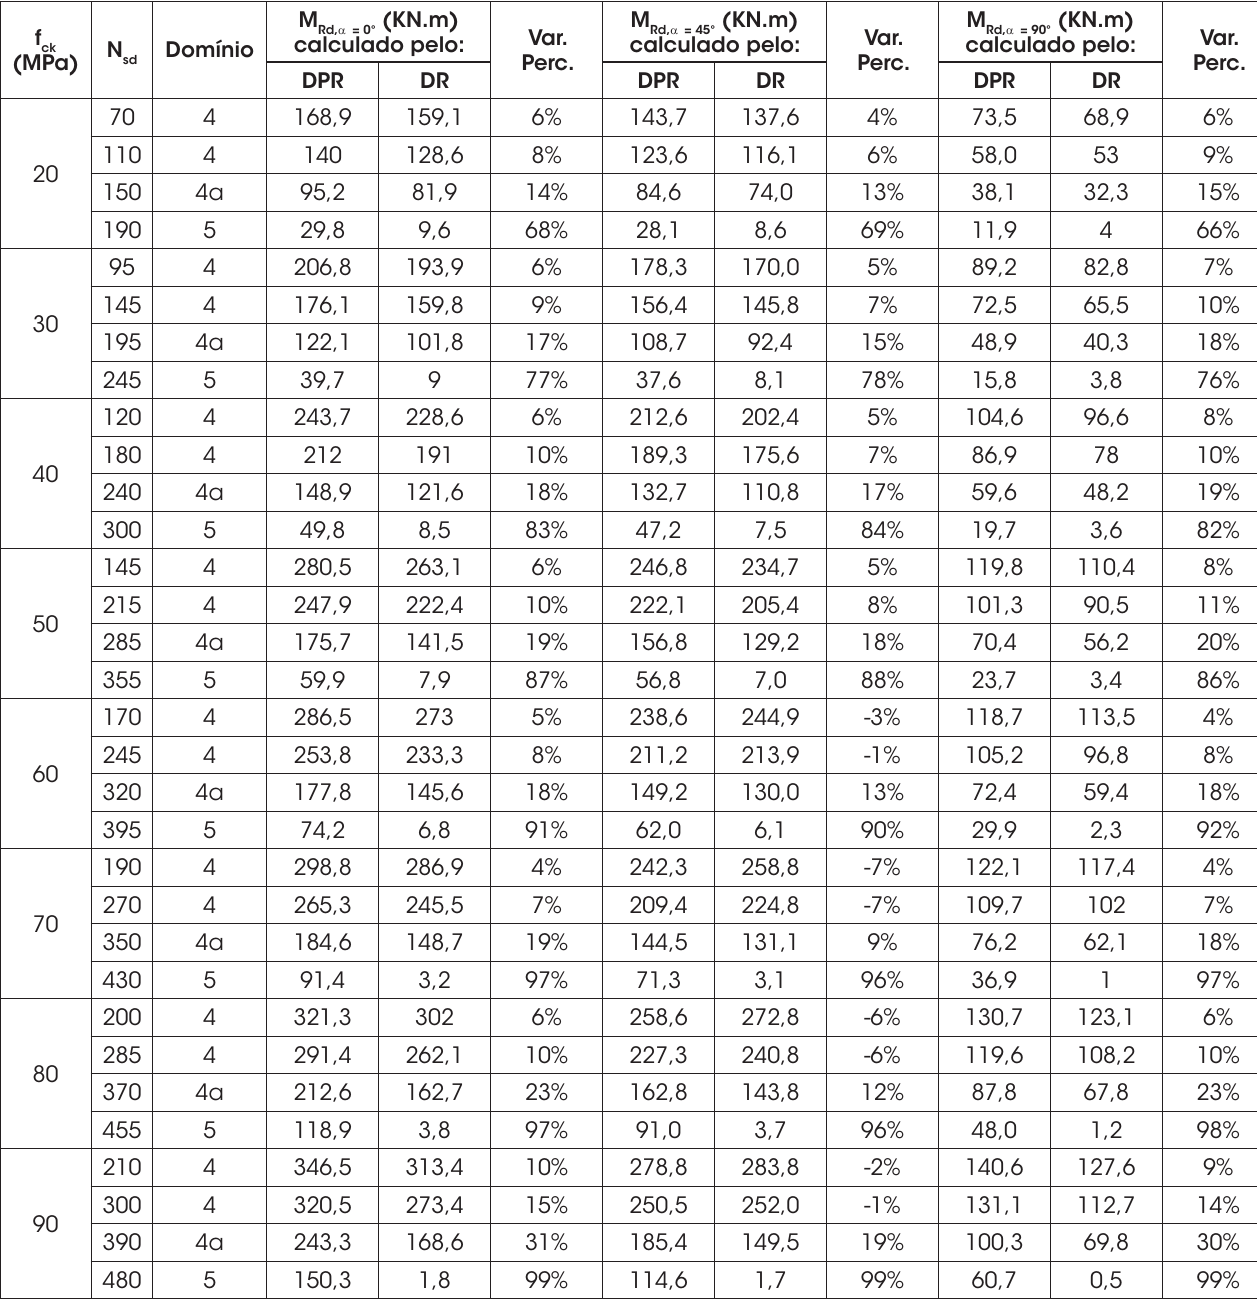
DPR = Diagrama Parábola Retângulo; DR = Diagrama Retangular; Var. Perc. = Variação percentual